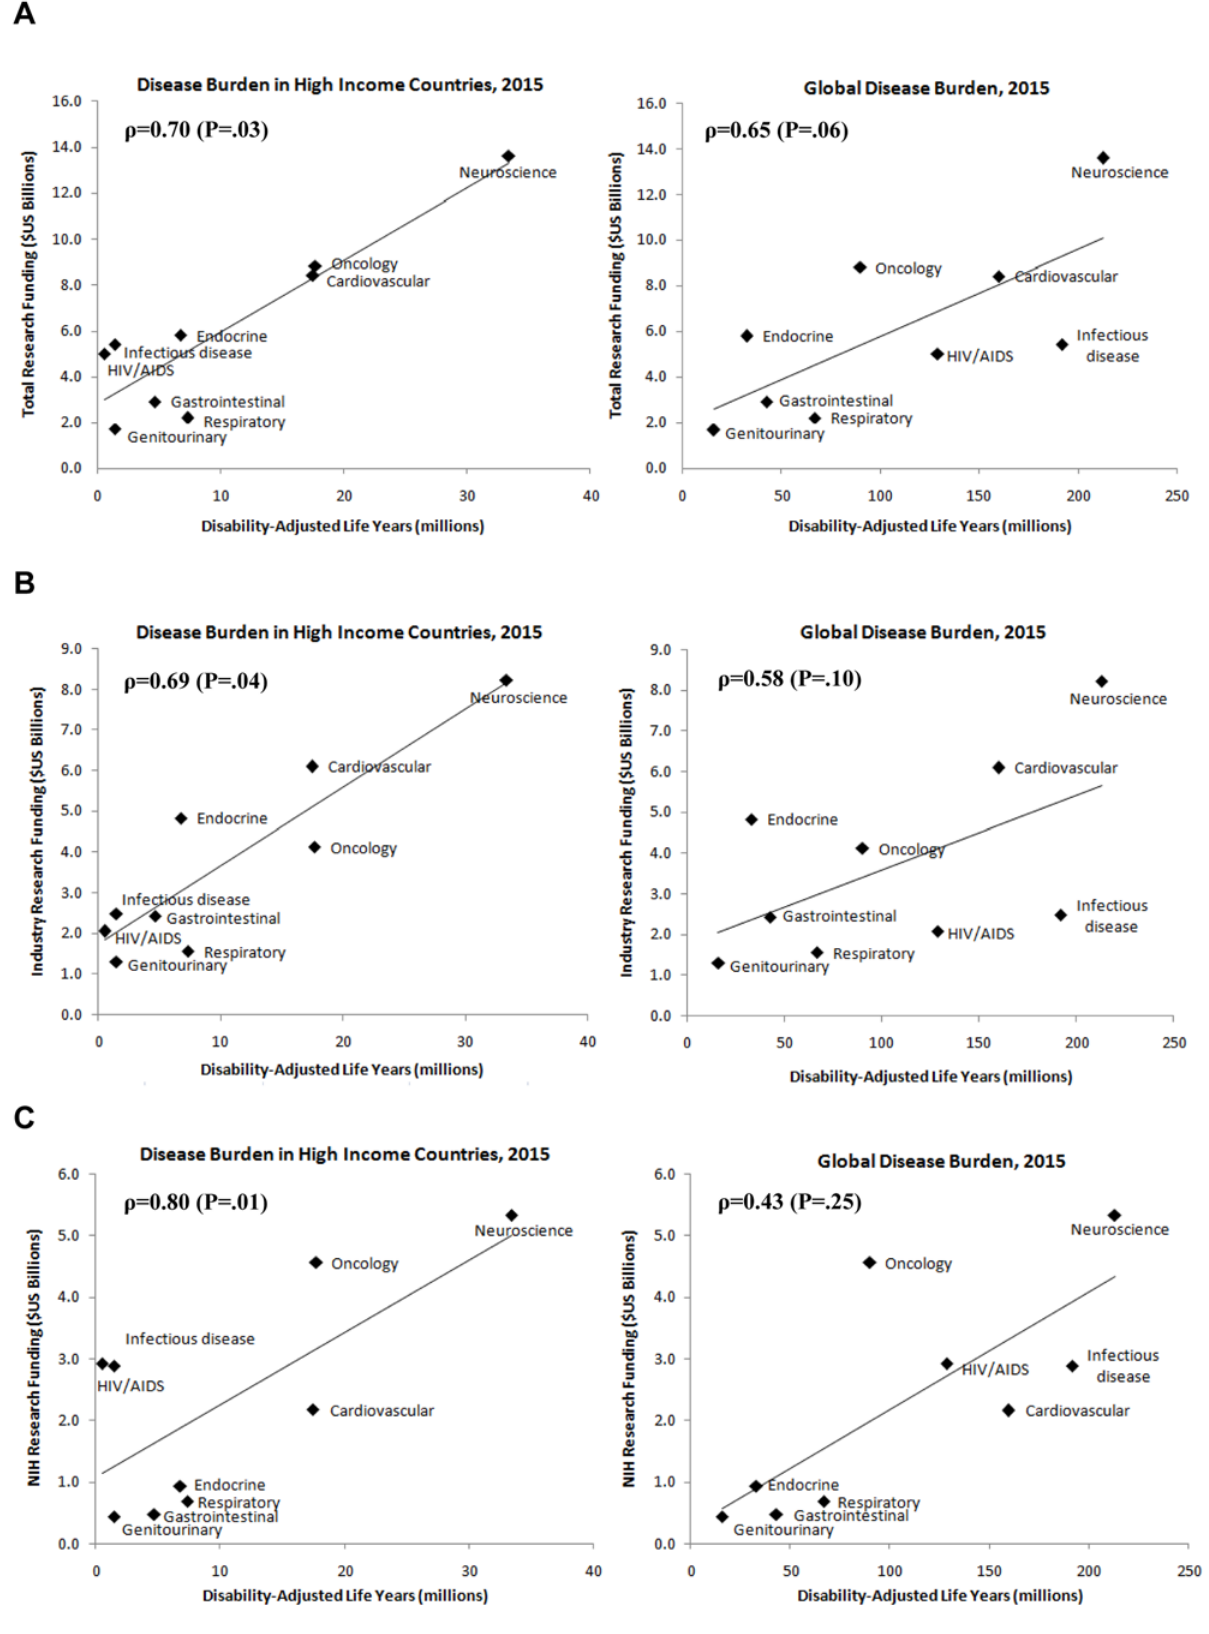
Figure 3. Correlation between a) total, b) industry, and c) NIH research funding in 2005 and projected disease burden in 2015 for high income countries and the